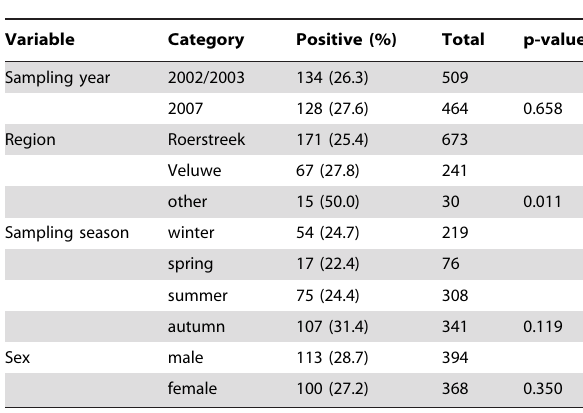
Table 2. Wild boar serum samples positive for antibodies against T. gondii by sampling year, region, sampling season and sex; and p-values for Pearson’s x 2 -statistic per